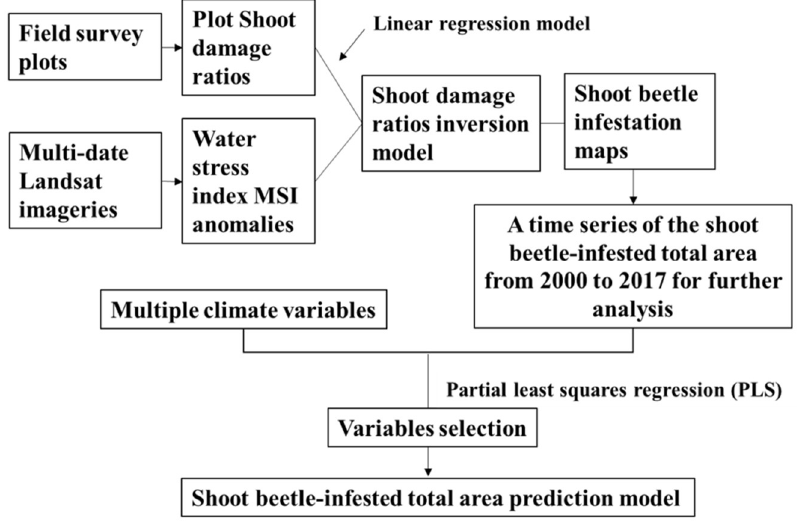
Figure 2. Flowchart of the variable selection processes and the development of a prediction model.